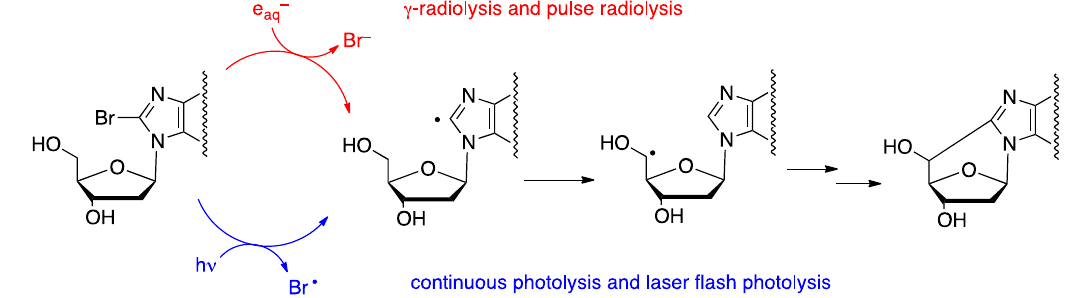
Figure 3. Bioinspired radical transformations for the synthesis of 5 ′ ,8-cyclopurines.